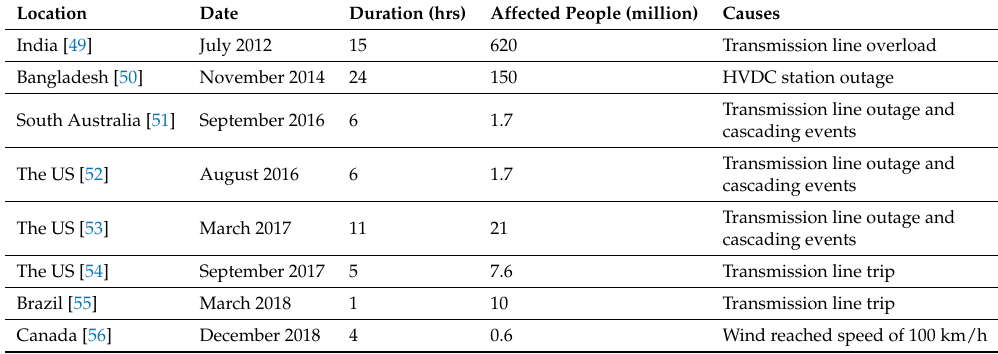
Major blackouts in modern power systems with substantial power-electronic-based (PE-based)